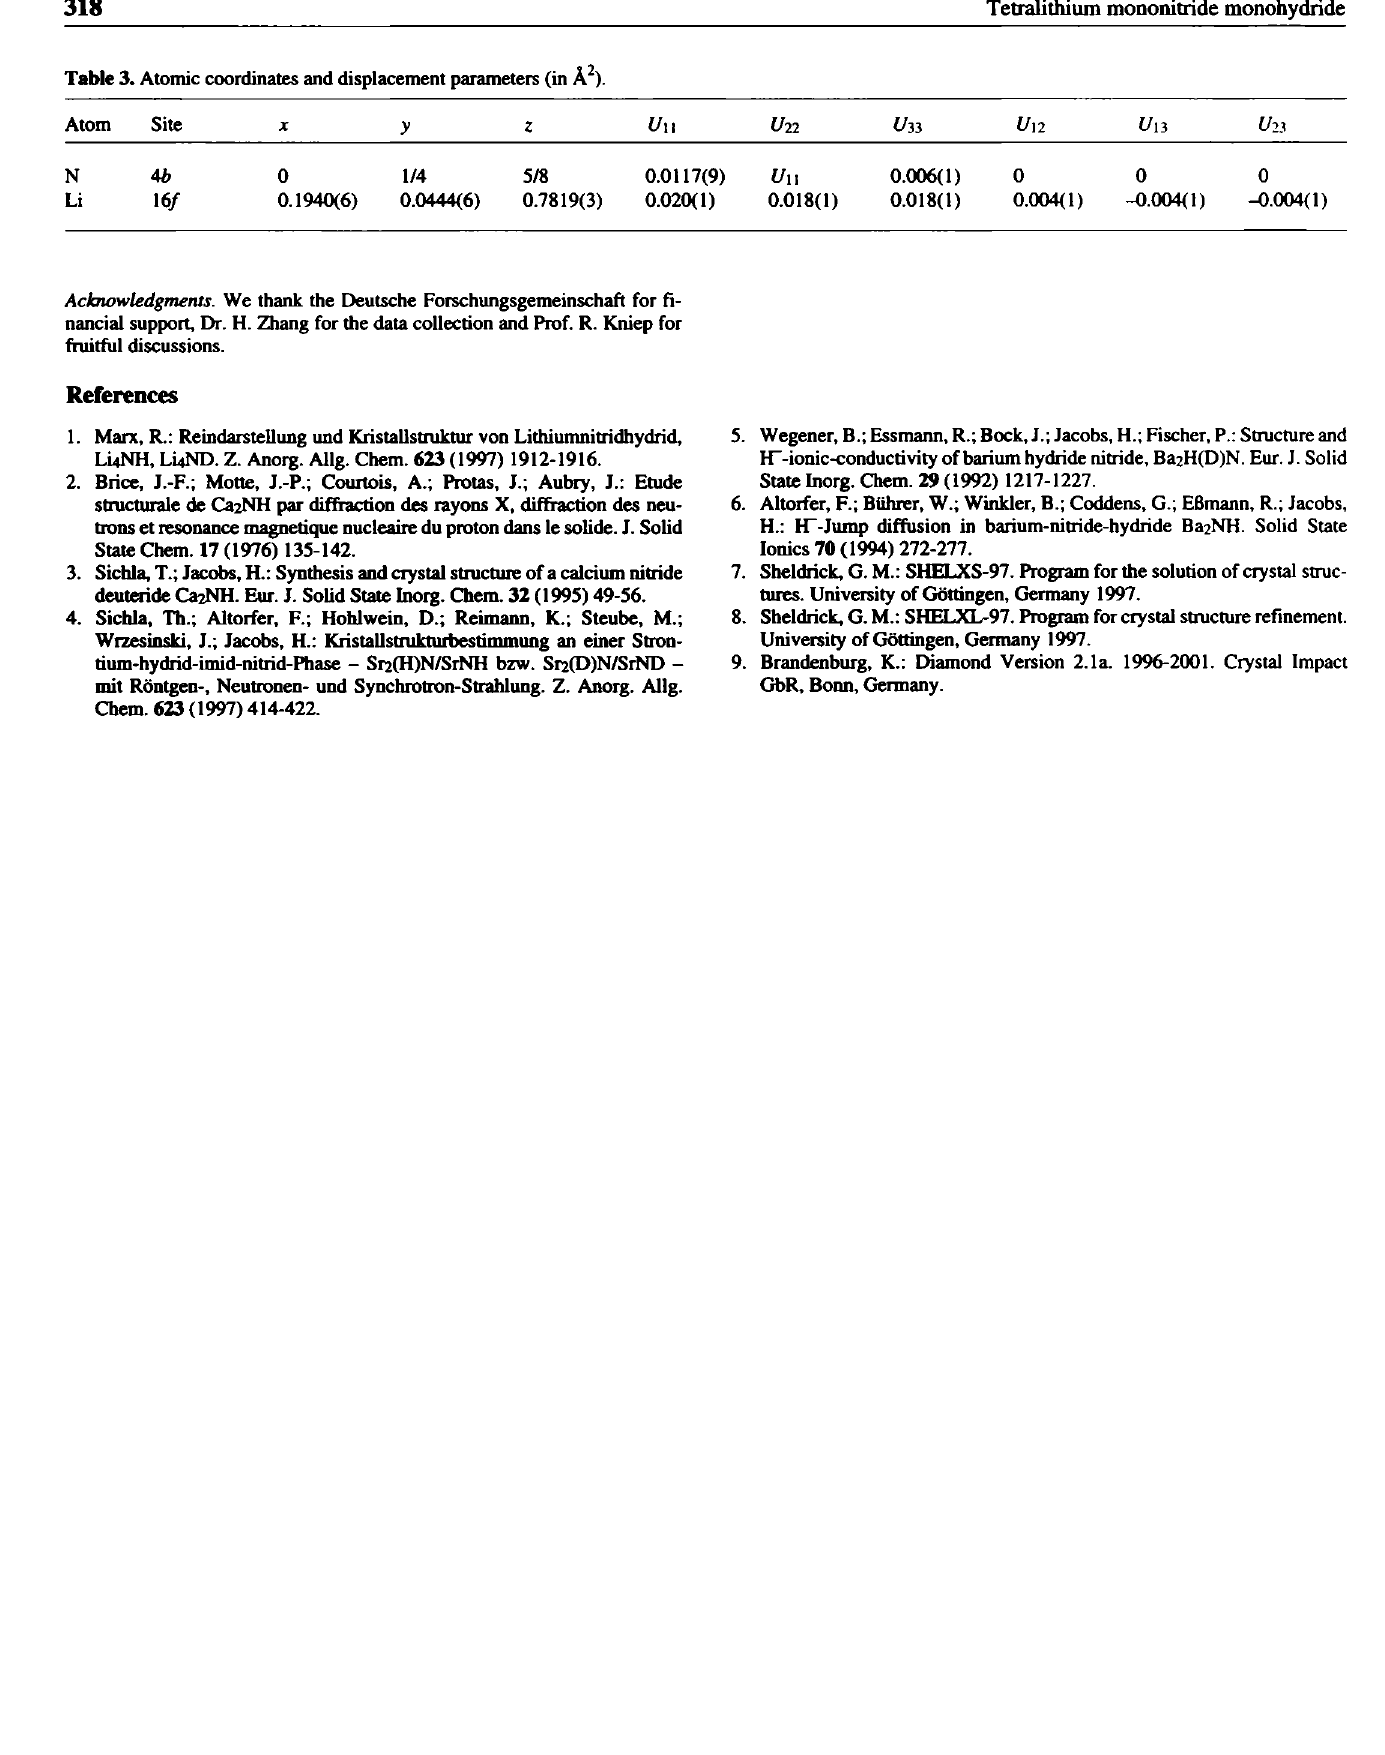
Table 3. Atomic coordinates and displacement parameters (in Â 2